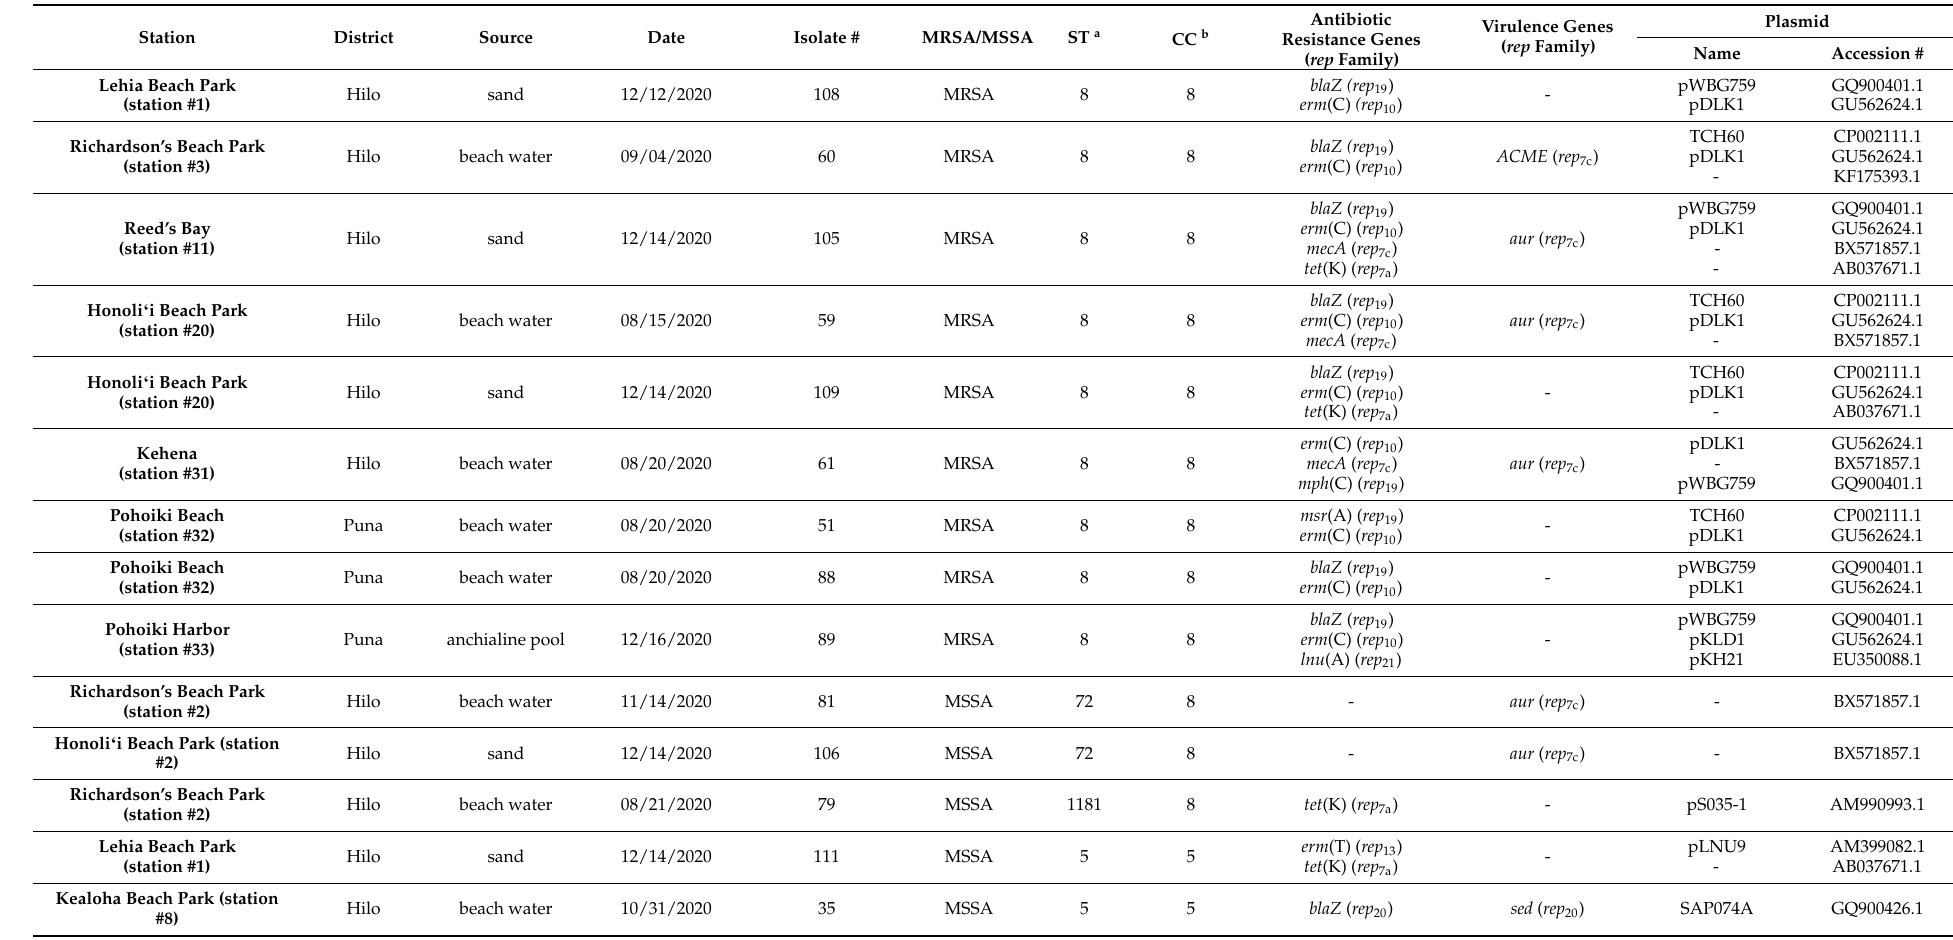
Table 3. Association of antibiotic resistance genes and/or virulence genes, and replicon families ( rep families) with